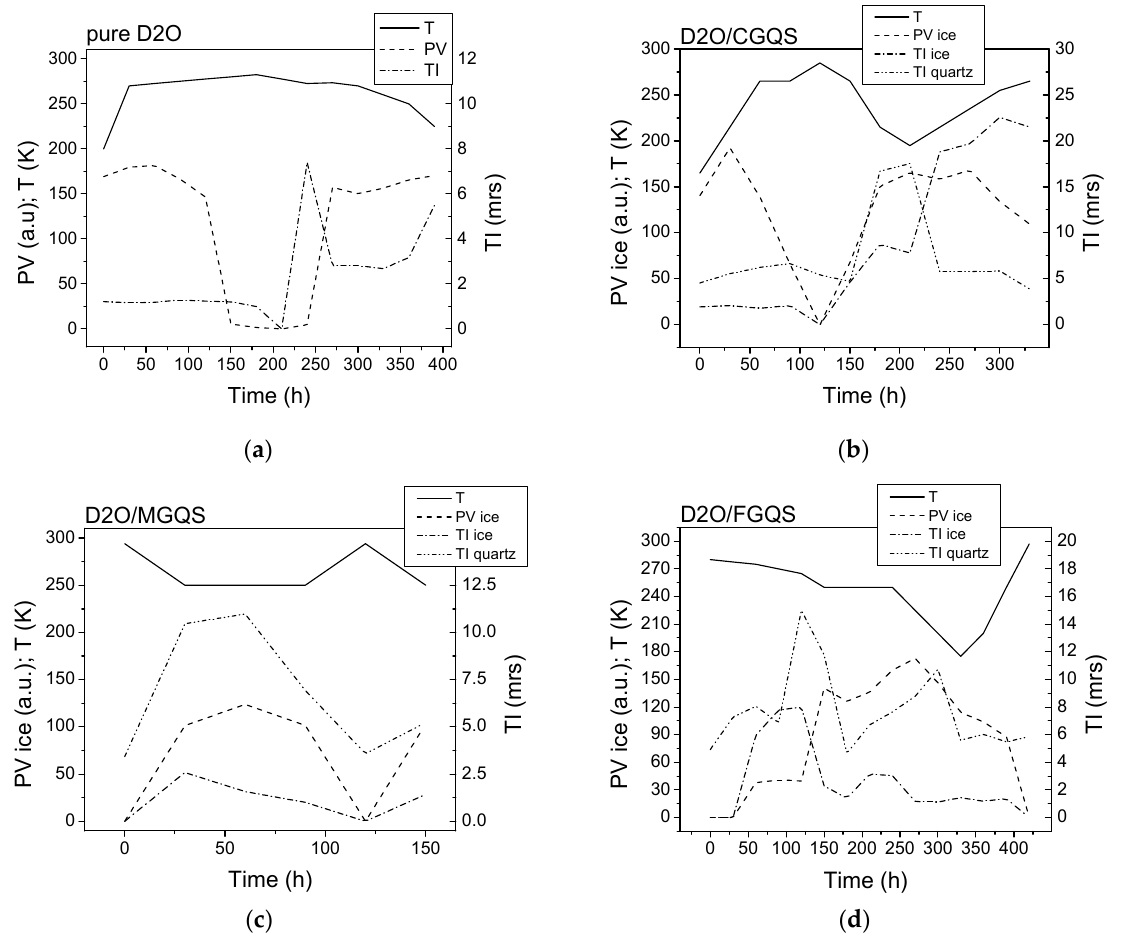
Figure 4. Evolution of the phase volume (PV) of Ih ice and texture indices (TI) of Ih ice and α -quartz during the indicated temperature courses (T): ( a ) pure D 2 O, ( b ) CGQS, ( c ) MGQS, and ( d ) Figure 2. O in the mixed samples amounts represents 3.5/1.